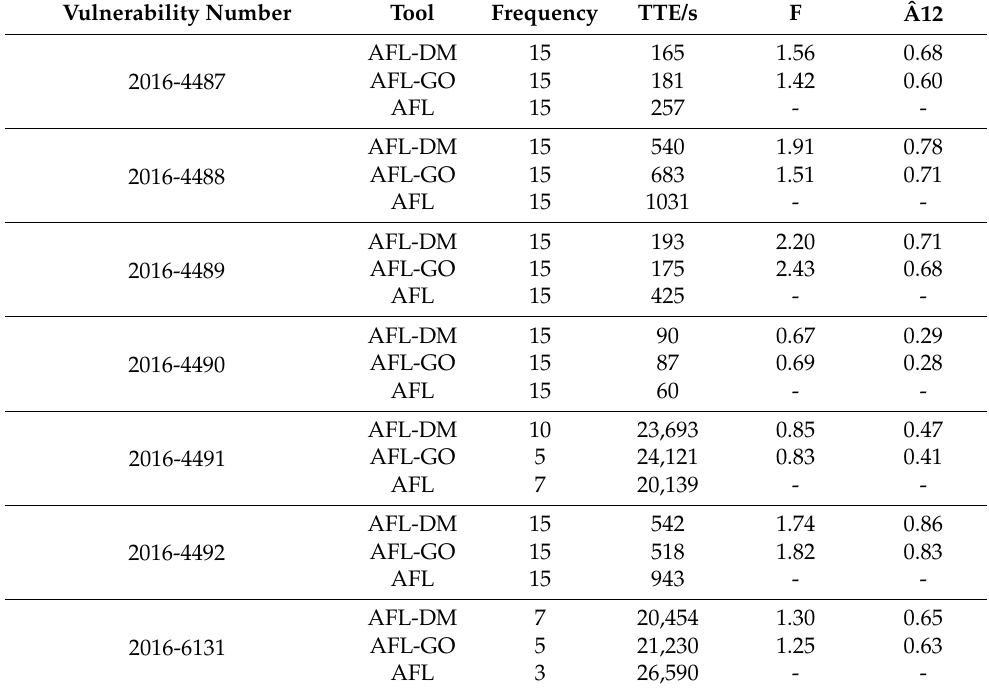
Table 1. Vulnerability reproduction results of GNU